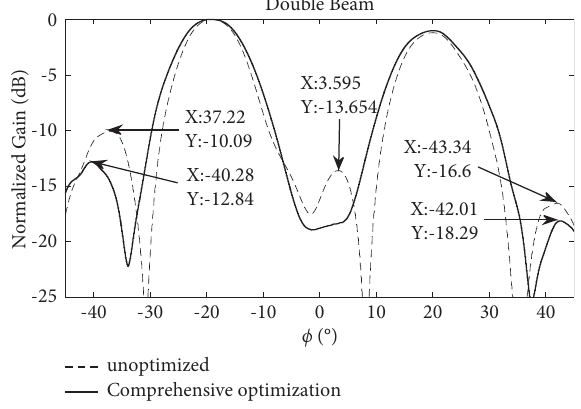
Figure 11: Two beams separated by 40 °